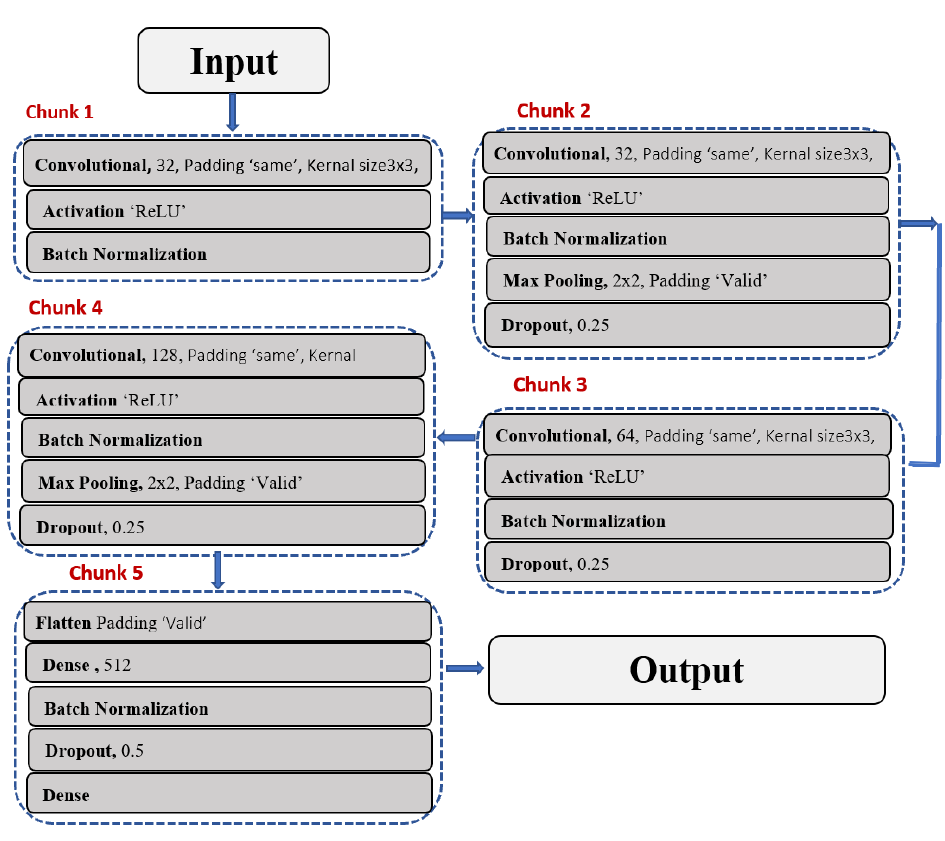
Figure 5. Proposed CNN-based Architecture with organizations of layers.